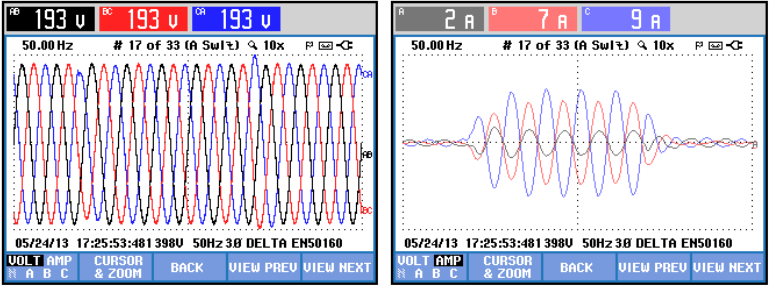
Figure 12. Single-phase 70% dip compensation.